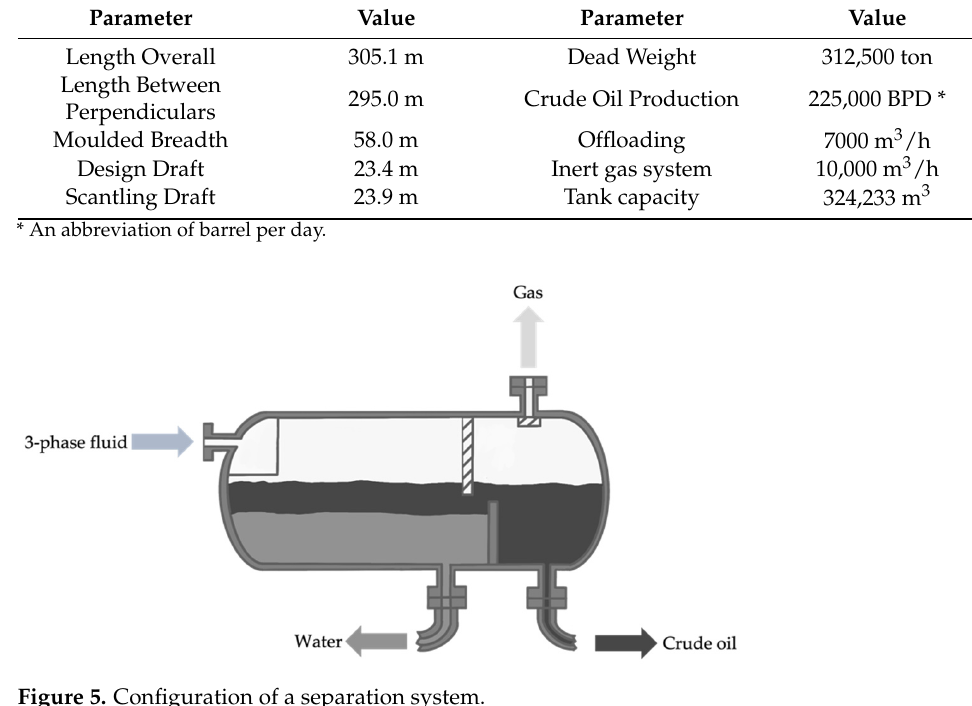
Figure 5. Configuration of a separation system.